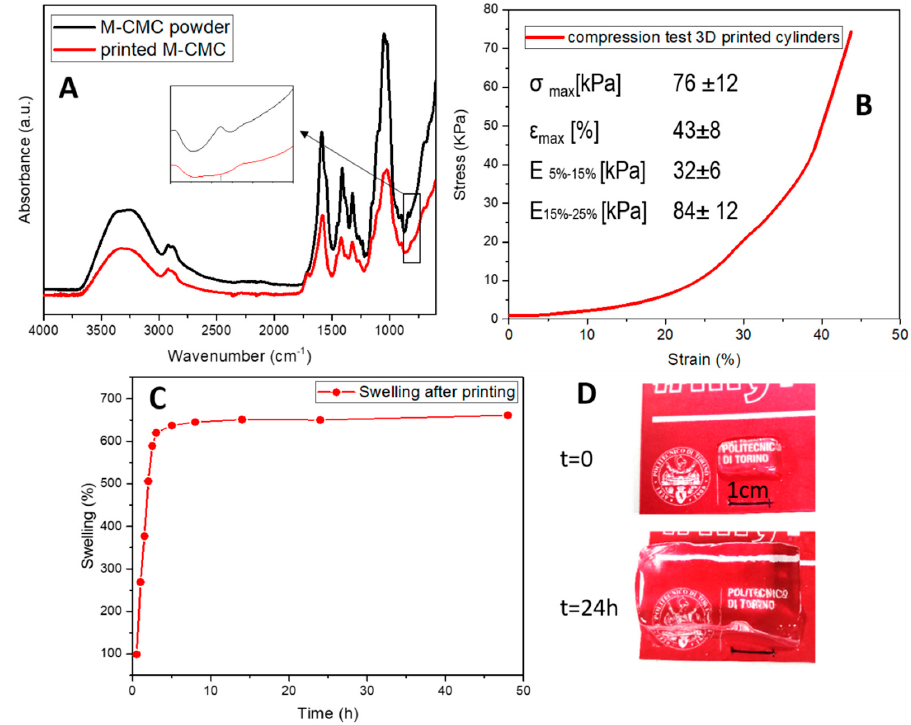
Figure 4. ( A ) FTIR spectra of the 3D-printed M-CMC hydrogel, ( B ) Stress–strain curve obtained from a compression test performed on 3D-printed cylinders. ( C , D ) Swelling of the 3D-printed hydrogel as printed.